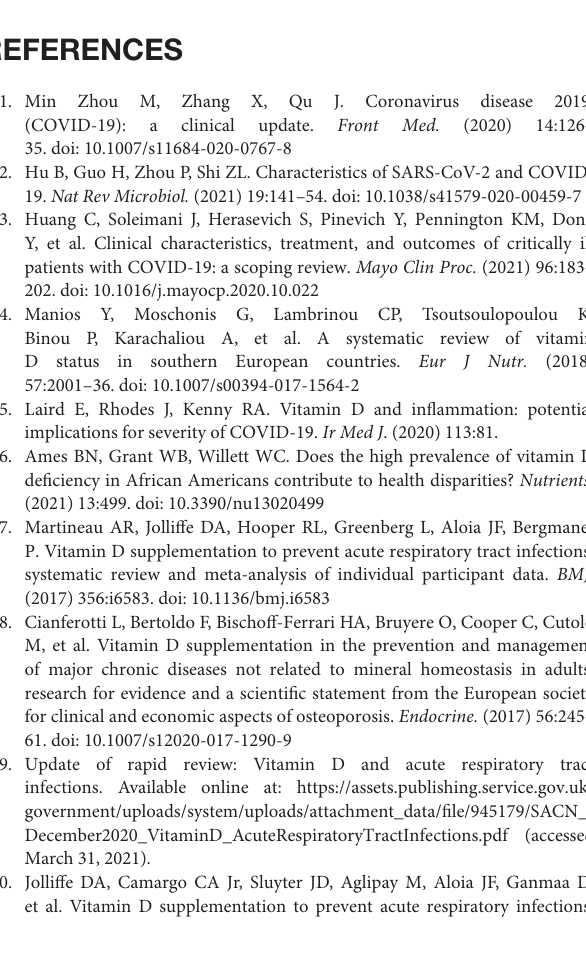
Supplementary Figure 1 | The forest-plots reporting the association between SARS-CoV-2 infection and vitamin D thresholds (severe vitamin D deficiency, vitamin D deficiency, and vitamin D insufficiency). < 25 nmol/L, 25OHD levels below 25 nmol/L; < 50 nmol/L, 25OHD levels below 50 nmol/L; < 75 nmol/L, 25OHD levels below 75 nmol/L. Supplementary Figure 2 | The forest-plot reporting the association between COVID-19 related hospitalization and vitamin D thresholds (severe vitamin D deficiency, vitamin D deficiency, and vitamin D insufficiency). COVID-19, Coronavirus Disease-2019; < 25 nmol/L, 25OHD levels below 25 nmol/L; < 50 nmol/L, 25OHD levels below 50 nmol/L; < 75 nmol/L, 25OHD levels below 75 nmol/L. Supplementary Figure 3 | The funnel plots and Egger’s test p -value for the association between admission to intensive care unit (ICU) or death and vitamin D status in COVID-19 patients. COVID-19, Coronavirus Disease-2019; ICU, intensive Care Unit; < 25 nmol/L, 25OHD levels below 25 nmol/L; < 50 nmol/L, 25OHD levels below 50 nmol/L; < 75 nmol/L, 25OHD levels below 75 nmol/L. Supplementary Figure 4 | Influence analysis on the impact of study-specific association estimate on pooled odds ratios. ICU, intensive Care Unit; < 25 nmol/L, 25OHD levels below 25 nmol/L; < 50 nmol/L, 25OHD levels below 50 nmol/L; < 75 nmol/L, 25OHD levels below 75